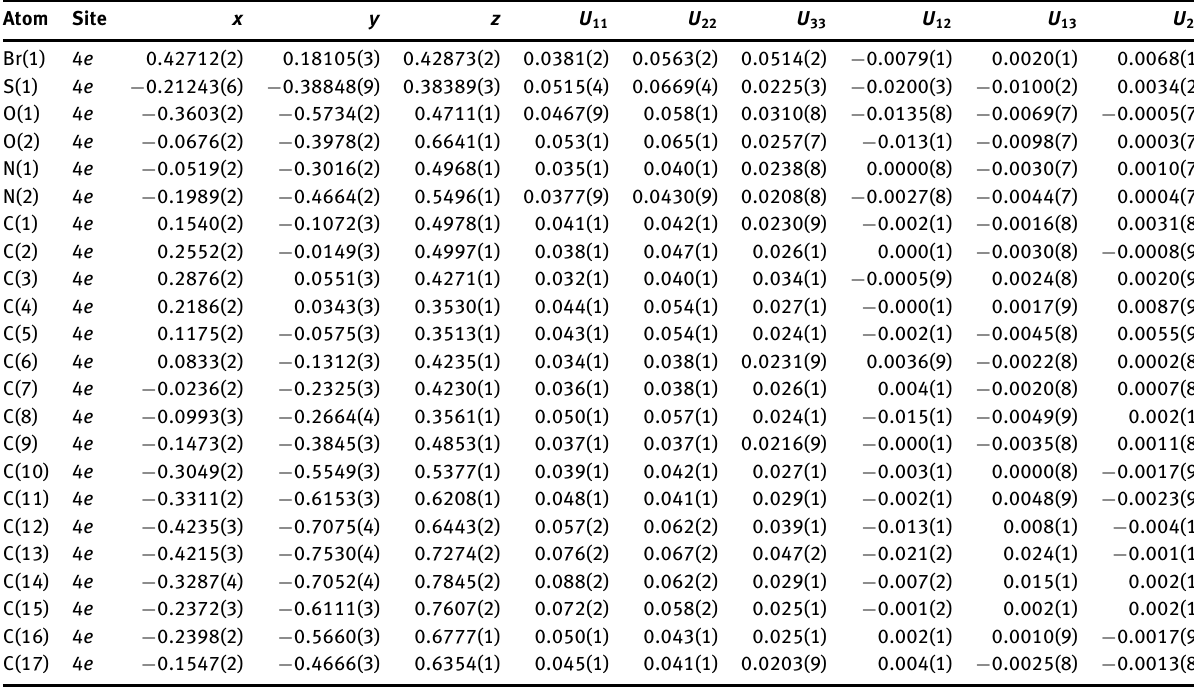
Table 3: Fractional coordinates and atomic displacement parameters (Å 2